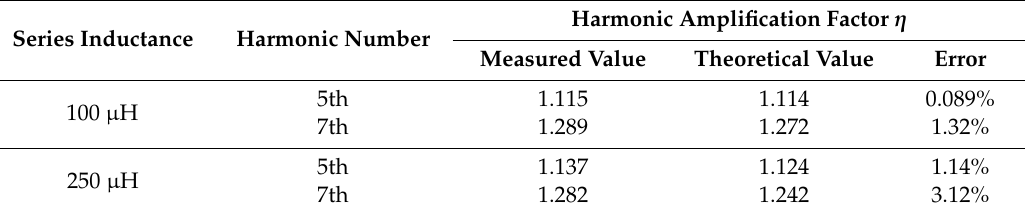
Table 4. Experimental calculation